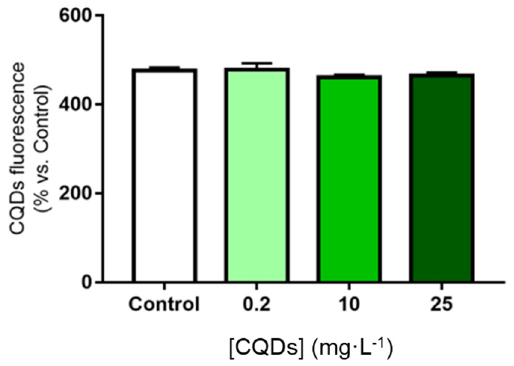
Figure 6. Fluorescence emission in 3T3-L1 cell cultures exposed for 6 h to increasing concentration of CQDs in the absence of serum. Control cells were cultured in medium (DMEM) alone. Measurements were carried out at fluorescence excitation wavelength of 365 nm and emission wavelength of 450 nm. Data (mean ± SEM of at least three independent experiments with three replicate wells per treatment) were analyzed by one-way ANOVA multiple comparison test followed by Fisher’s LSD test.